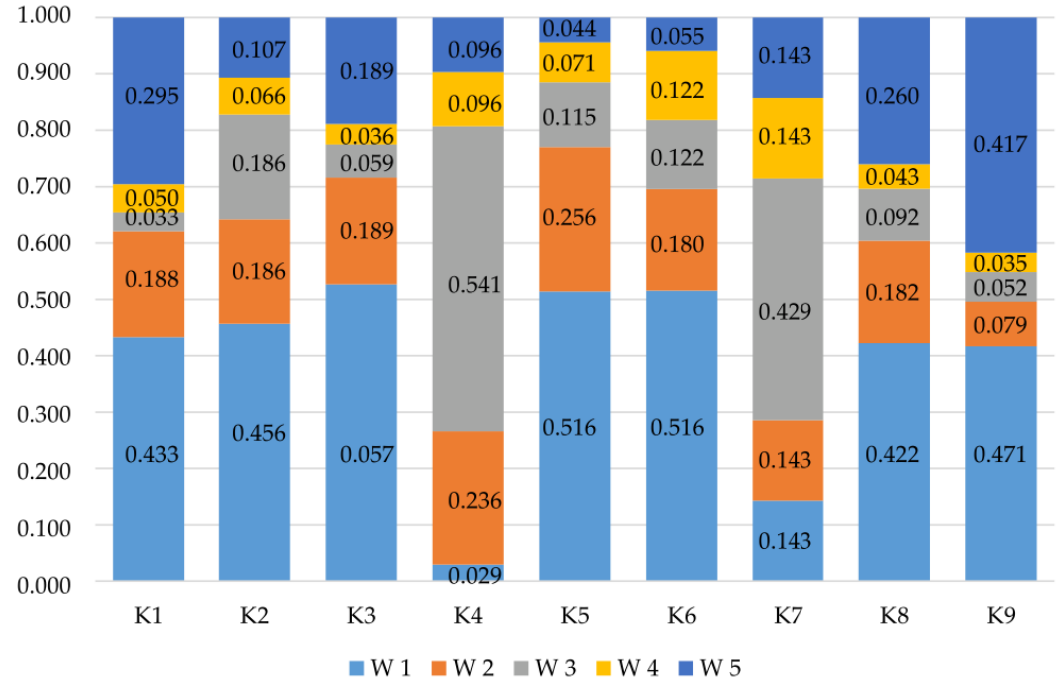
Figure 3. Weight coefficients calculated by the AHP analysis.